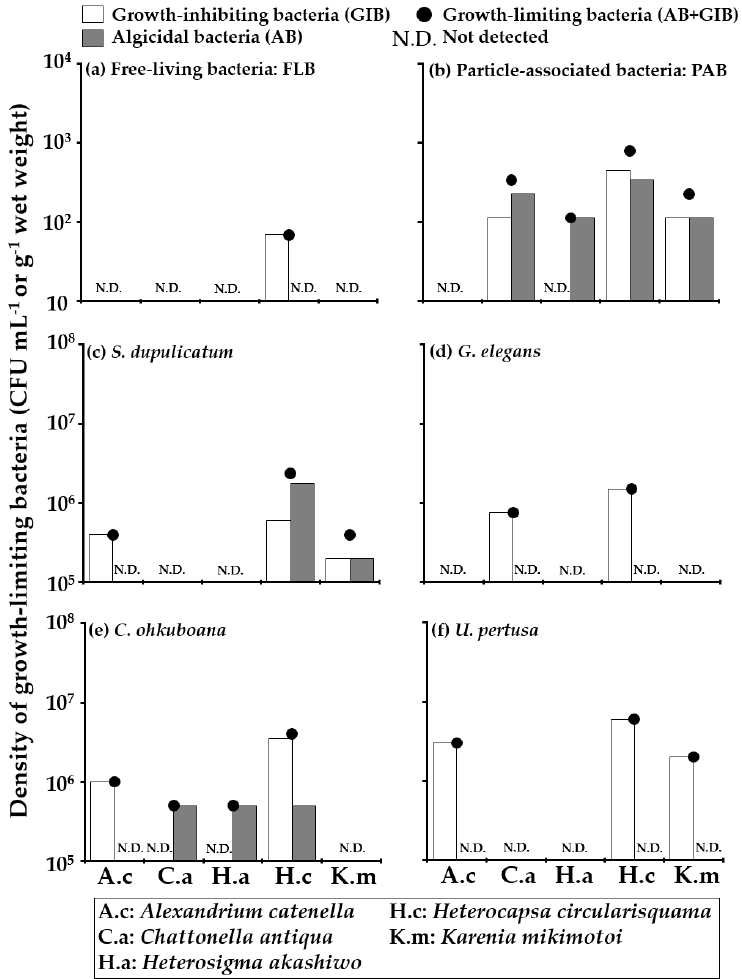
Figure 5. The densities of growth-limiting bacteria detected from seawater ( a ): FLB, ( b ): PAB and four macroalgal species ( c ): S. dupulicatum , ( d ): G. elegans , ( e ): C. ohkuboana and ( f ): U. pertusa collected at Stn.2. The densities of growth-limiting bacteria ( ●) are expressed as the sum of algicidal bacteria (AB: ) and growth-inhibiting bacteria (GIB: ). The tested HAB species and their abbreviations are displayed at the bottom.